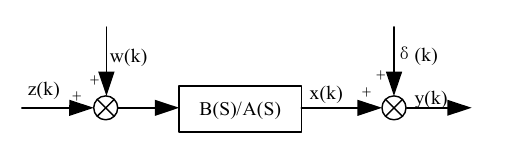
Figure 1. Block diagram of the mathematical model of the train